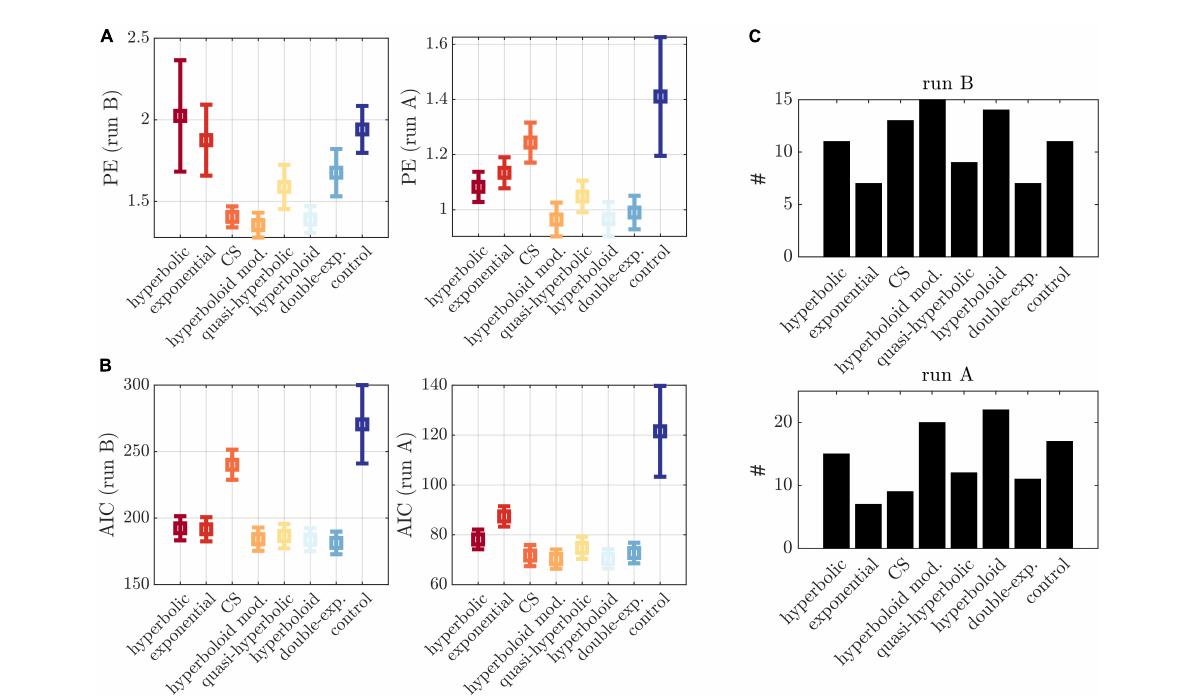
FIGURE4 Model comparisons. (A) Left: PE in run B based on models inferred on run A for different models ( x -axis). Right: PE in run A based on models inferred on run B for different models ( x -axis). (B) AIC evaluated on run B (left) and run A (right). (C) Number of individuals ( y -axis) with lowest PE for each model ( x -axis) for run B (top) and run A (bottom), applying a tolerance threshold of 0.01. Cases with multiple minima were counted multiple